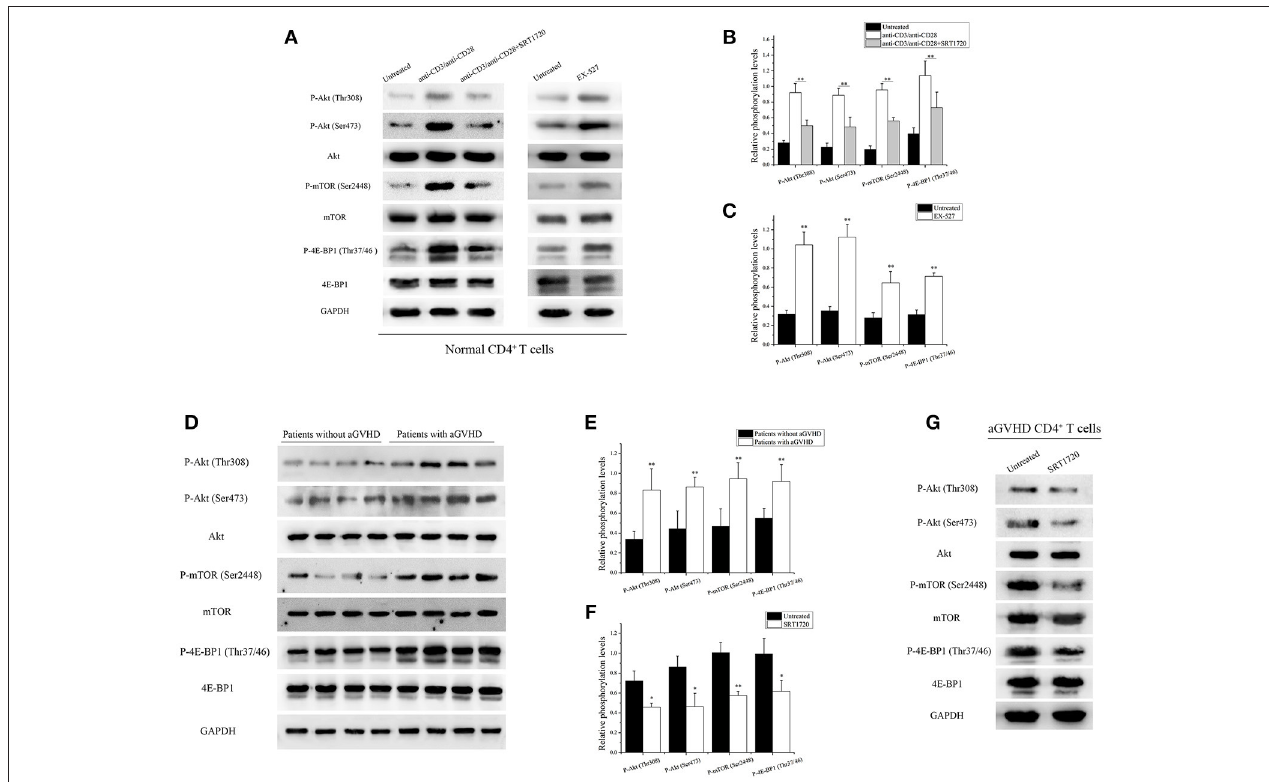
FIGURE 3 | SIRT1 targeting of mTOR pathway to inhibit CD4 + T cell activation. (A) (left) Representative western blotting result for relative phosphorylation of Akt, mTOR, 4E-BP1 in CD4 + T cells unstimulated or stimulated, treated or not with the SRT1720. (right) Representative western blotting result for relative phosphorylation of Akt, mTOR, 4E-BP1 in CD4 + T cells treated or not with EX-527. (B,C) Quantitative analysis of the band intensities for phosphorylation levels normalized by total protein levels. (D) Representative western blotting result for relative phosphorylation of Akt, mTOR, 4E-BP1 in CD4 + T cells from patients with aGVHD ( n = 10) and patients without aGVHD ( n = 10). (E,F) Quantitative analysis of the band intensities for phosphorylation levels normalized by total protein levels. (G) Representative western blotting result for relative phosphorylation of Akt, mTOR, 4E-BP1 in CD4 + T cells from patients with aGVHD treated or not with SRT1720. Data are presented as the mean ± SD of the same experiments performed in three aGVHD patients. * p < 0.05, ** p <